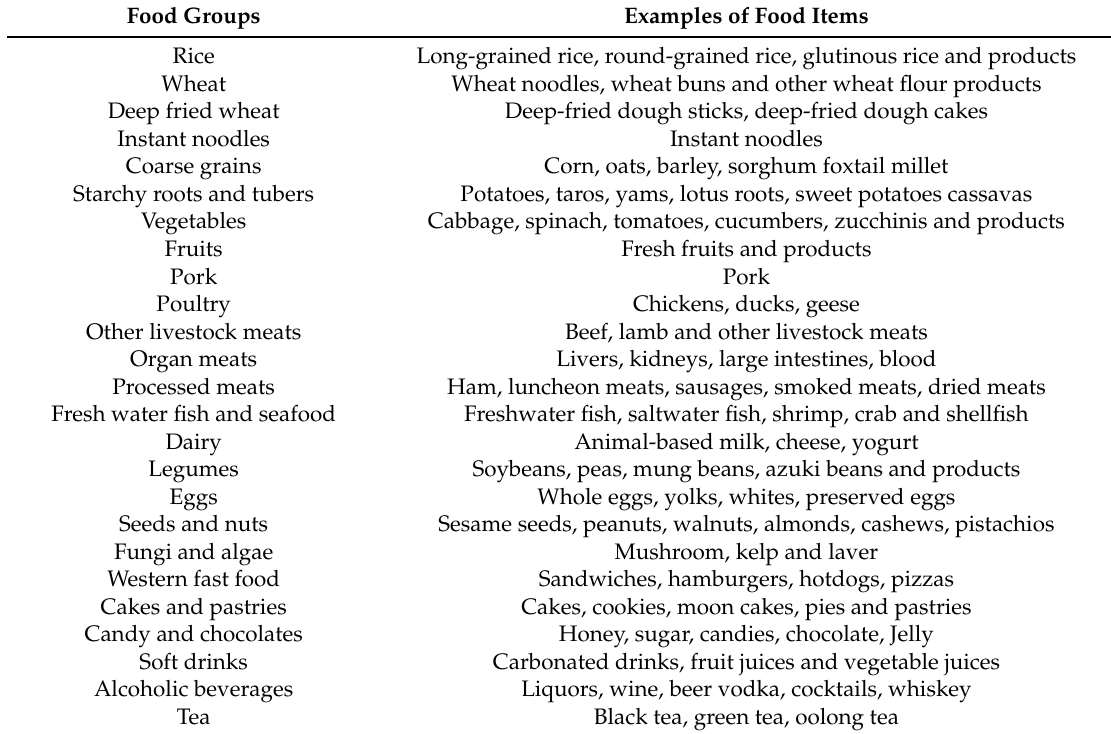
Table 1. Food groups in the factor